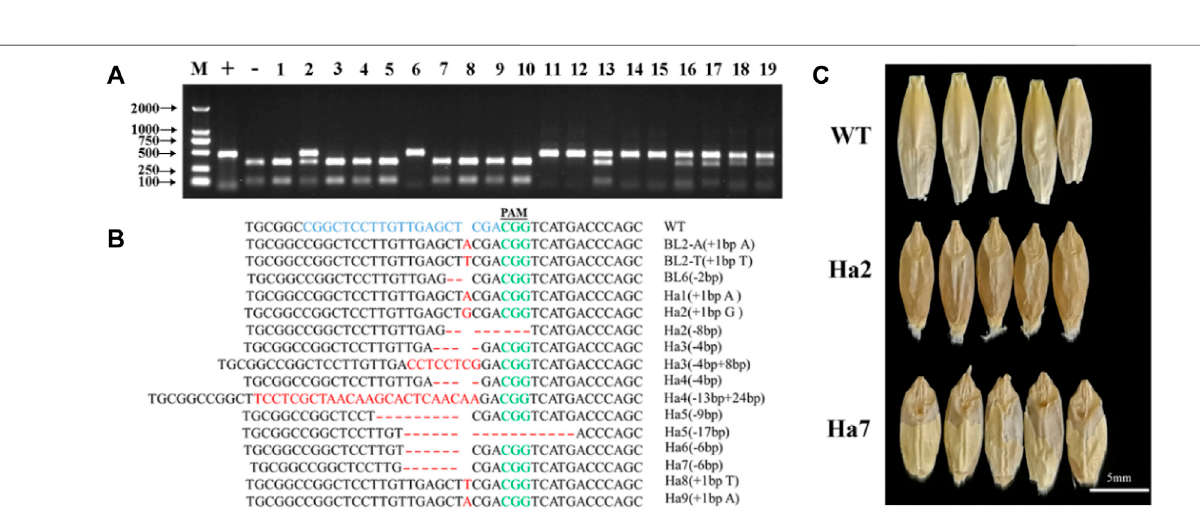
FIGURE2| Detectionandphenotypingof HvNud mutationsintransgenicbarleyplants. (A) PCRproductsof HvNud digestedwith Sac Irestrictionenzyme,M:DNA marker; +: positive control; − : negative control; 1 – 10: B1-BL10; 11 – 19: Ha1 – Ha9. (B) InDel mutations in the HvNud gene in edited T 0 transgenic barley plants. Nucleotidebasesshowninreddifferfromthetargetsequence inthesgRNA. (C) Phenotype ofT 1 grainsharvested frommutantplantsincomparison toWTgrainandT 1 grains collected from HvNud knockout T 0 mutants. WT: wild type without threshing; Ha2: frame-shift mutation after threshing; Ha7: 6 bp deletion mutation after